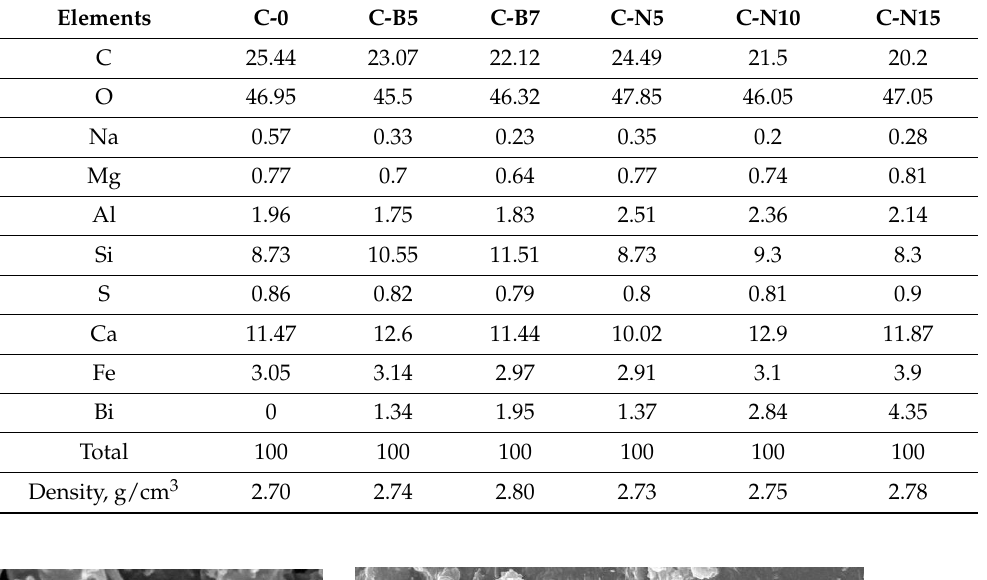
Table 2. Elemental composition and densities of concrete samples.